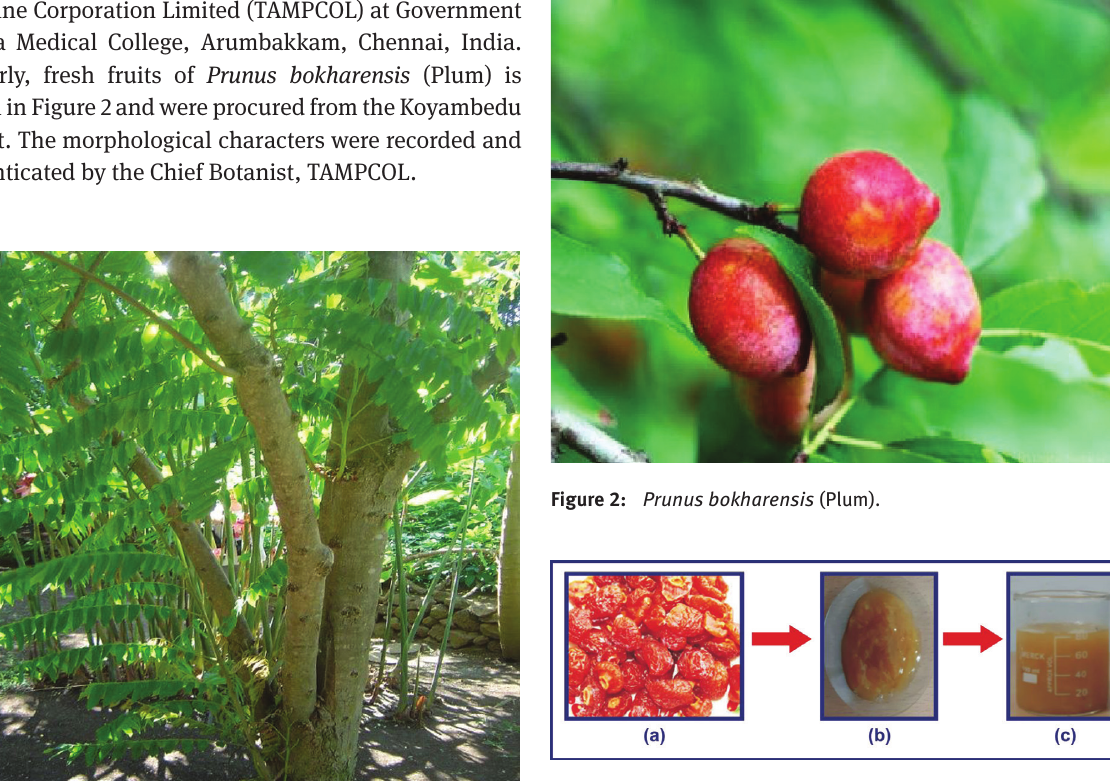
Figure 1: Averrhoa bilimbi .